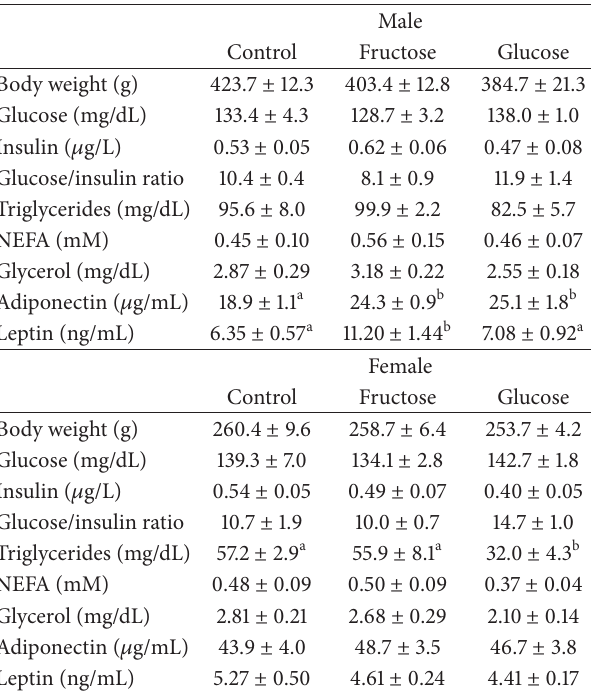
Table 2: Plasma analytes in fasted 91-day-old progeny from fructose- or glucose-supplemented